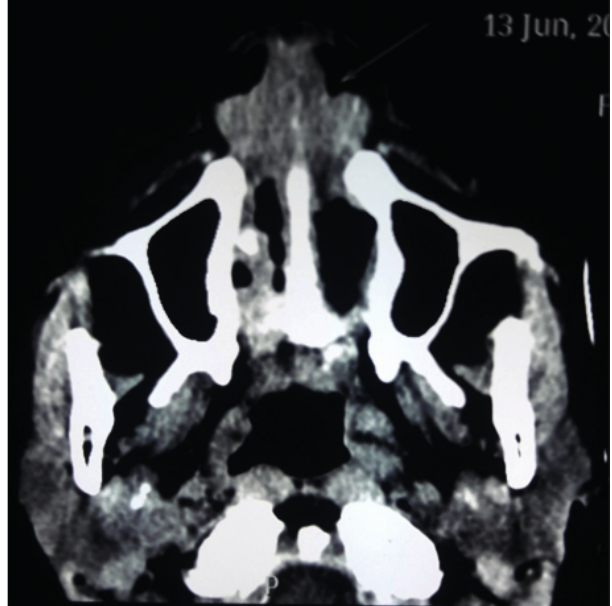
Figure 3. Tissue mass filling the nasal vestibule (case 1).